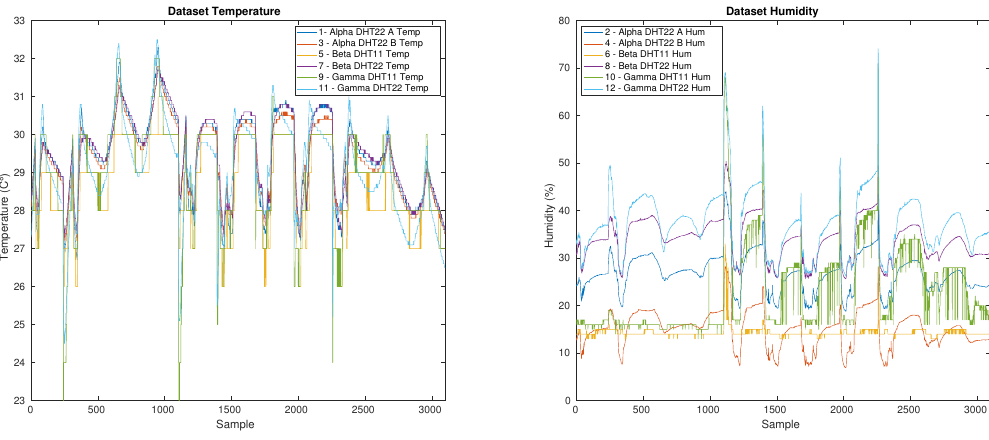
Figure 8. Measured temperature and humidity